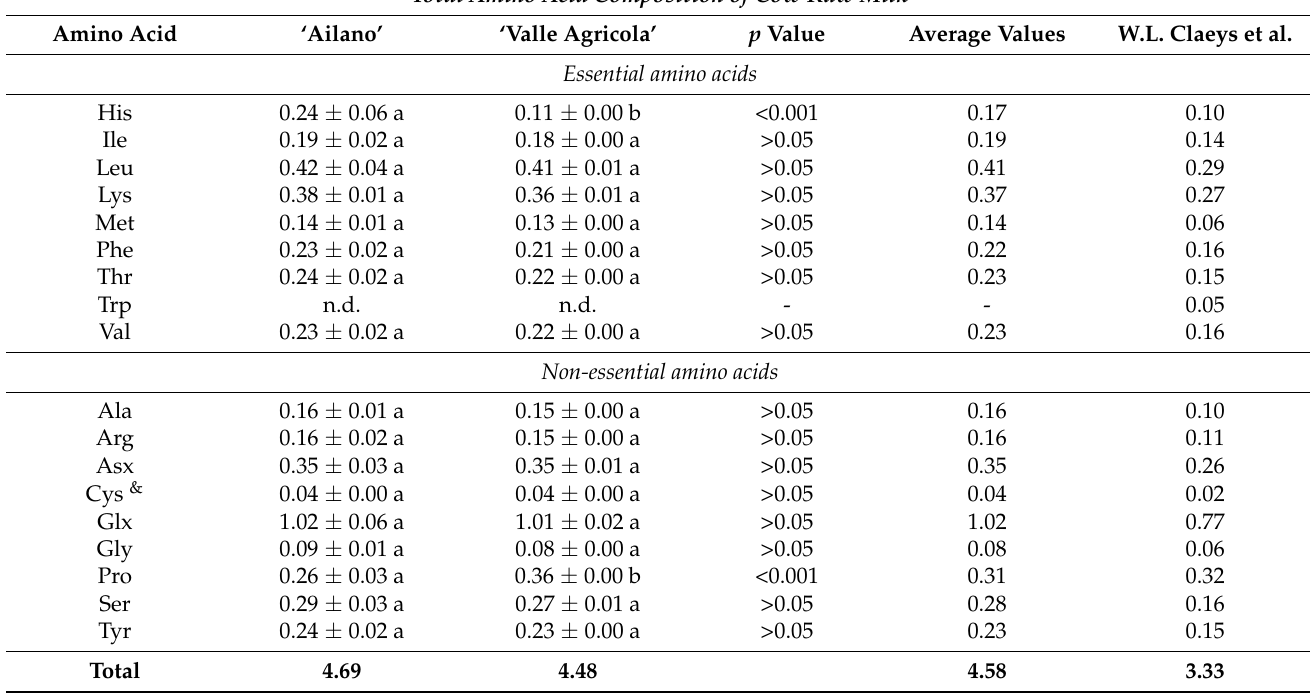
Table 1. Total amino acid composition of cow raw milk from ‘Ailano’ and ‘Valle Agricola’. Values are means ( ± SD) and are expressed as g per 100 g of milk. See Section 2.2 of Materials and Methods section for more details. Total Amino Acid Composition of Cow Raw Milk Amino Acid ‘Ailano’ ‘Valle Agricola’ p Value Average Values W.L. Claeys et al. containing compounds [21]. Essential amino